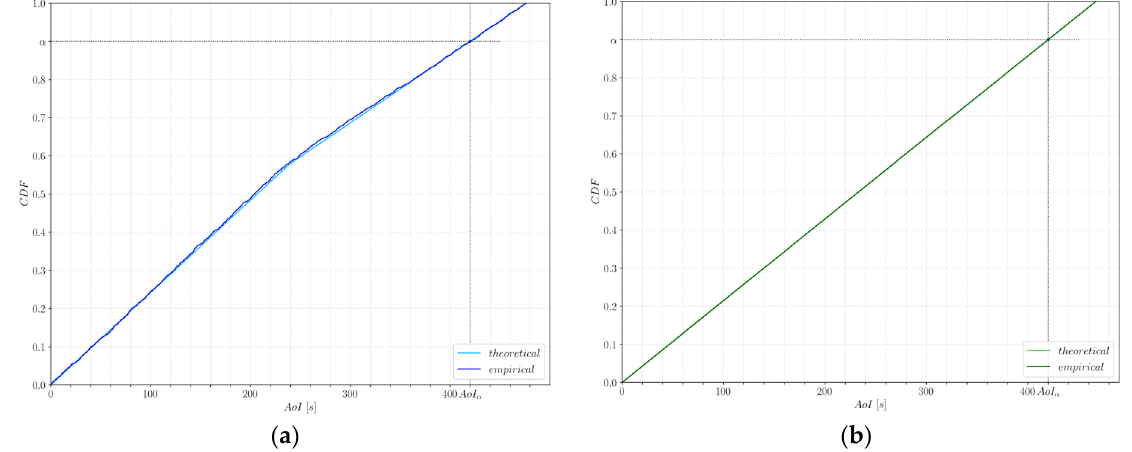
Figure 12. AoI CDF with 10 periodic servers: ( a ) first scenario, ( b ) second scenario.